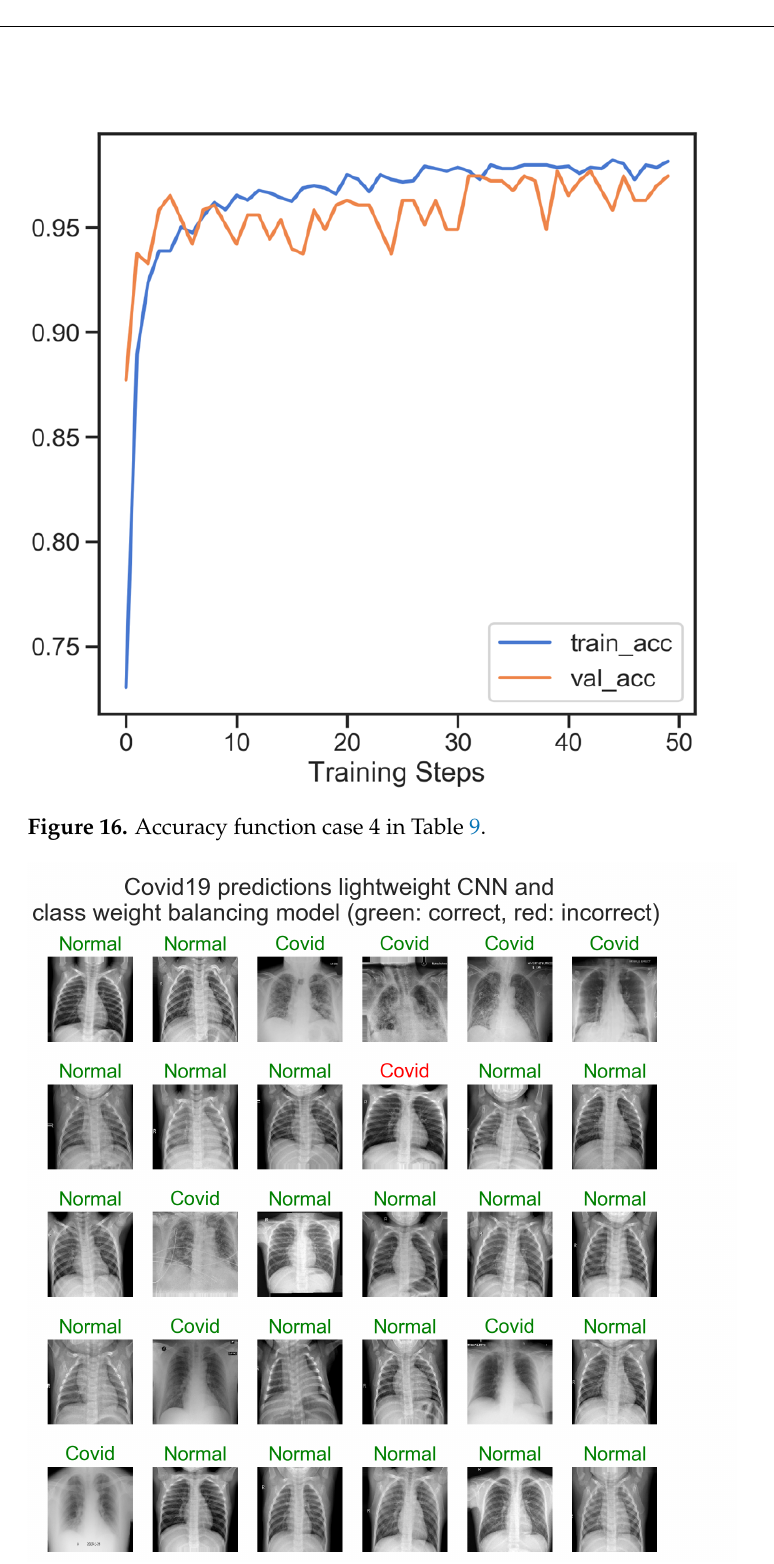
Figure 17. Model prediction case 4 in Table